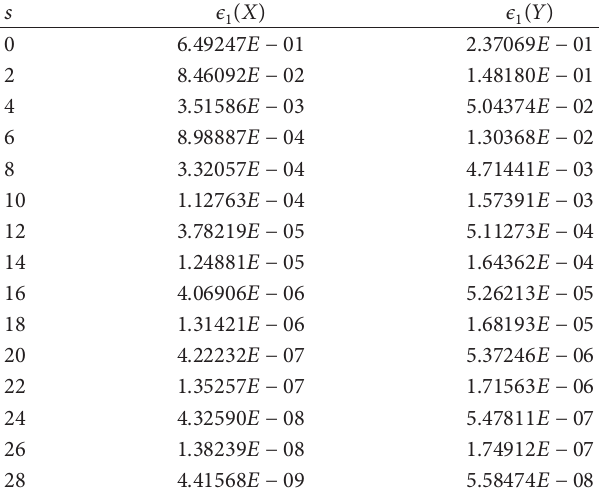
Table 4: Error analysis for Example